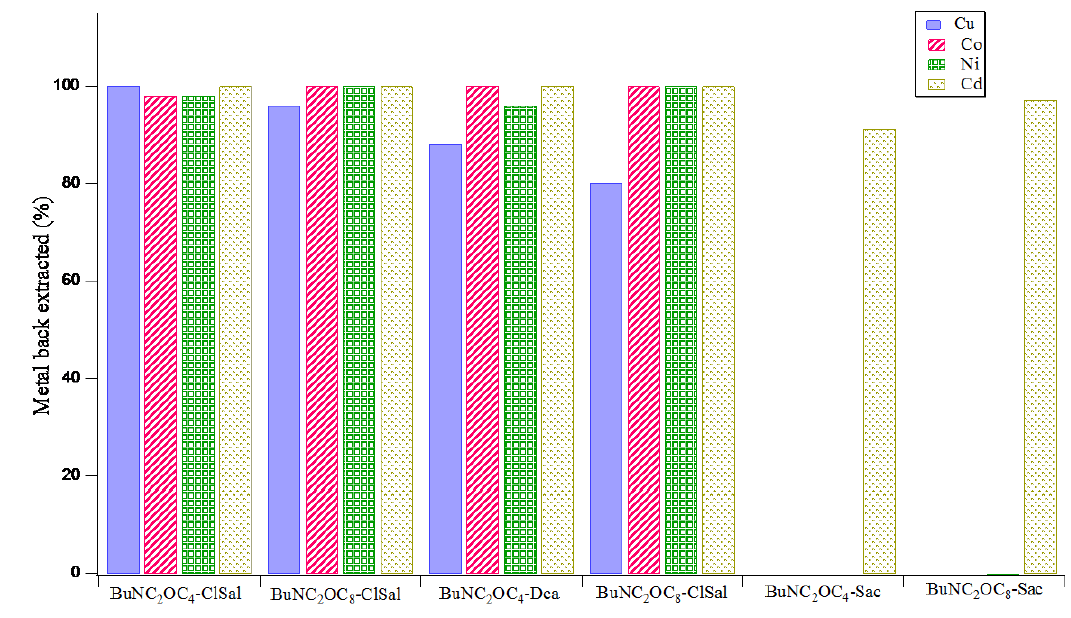
Figure 8. Extraction and back-extraction yield (%E) for M(II).